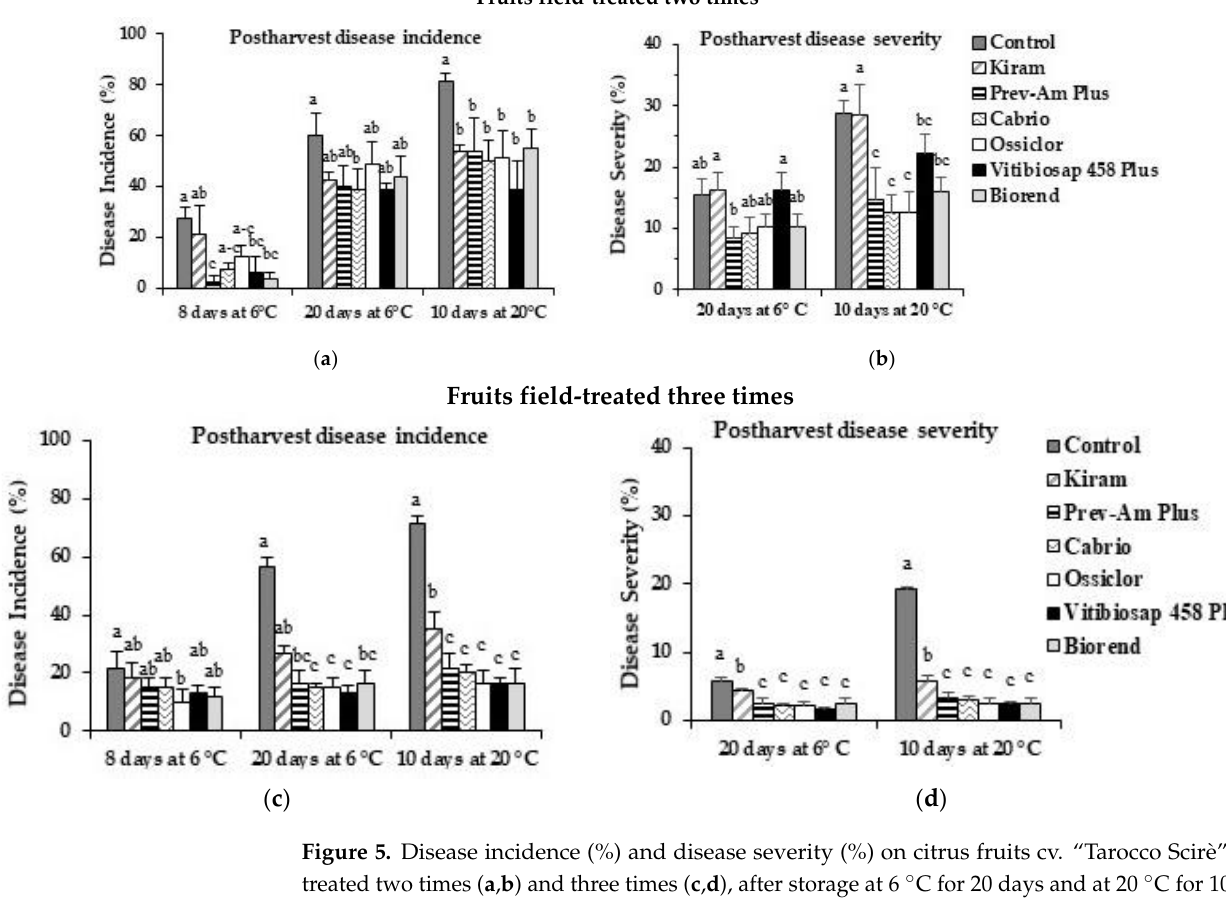
Figure 5. Disease incidence (%) and disease severity (%) on citrus fruits cv. “Tarocco Scirè” field- treated two times ( a , b ) and three times ( c , d ), after storage at 6 °C for 20 days and at 20 °C for 10 days. Bars represent the standard error of the mean (SEM). Columns with different letters are statistically different according to Fisher’s least significance difference test (LSD) at p -value < 0.05.